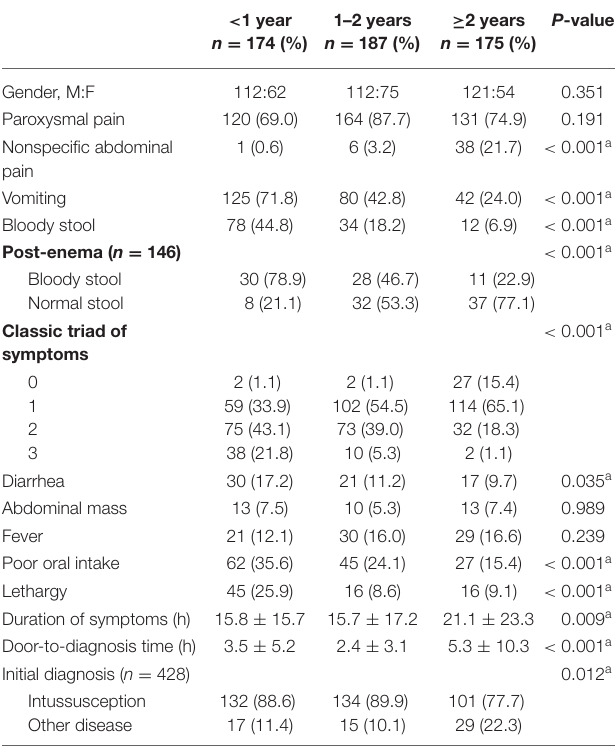
TABLE 1 | Clinical findings of enrolled patients in different age